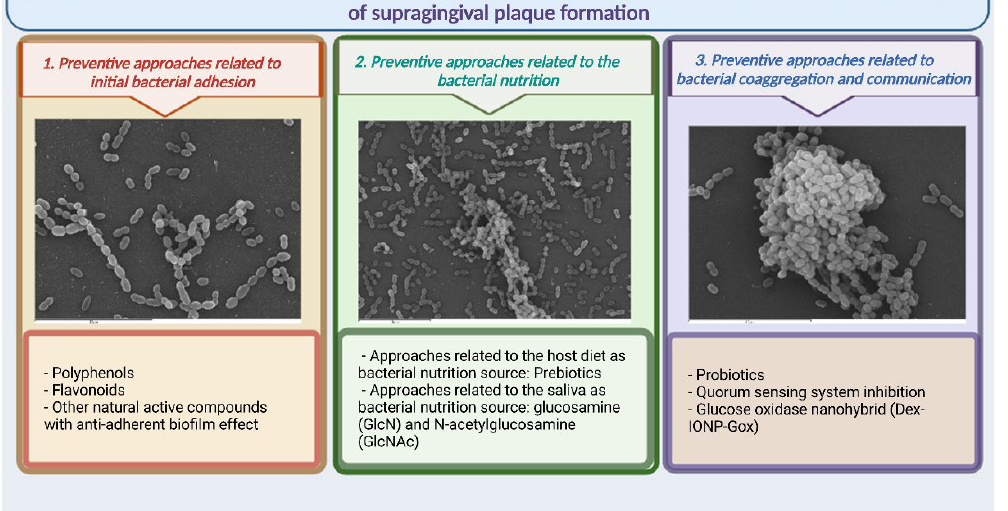
Figure 2. Summary of possible therapeutic approaches presented in the revision aimed at strategies to combat caries by maintaining the integrity of biofilm and homeostasis during the rapid phase of supragingival plaque